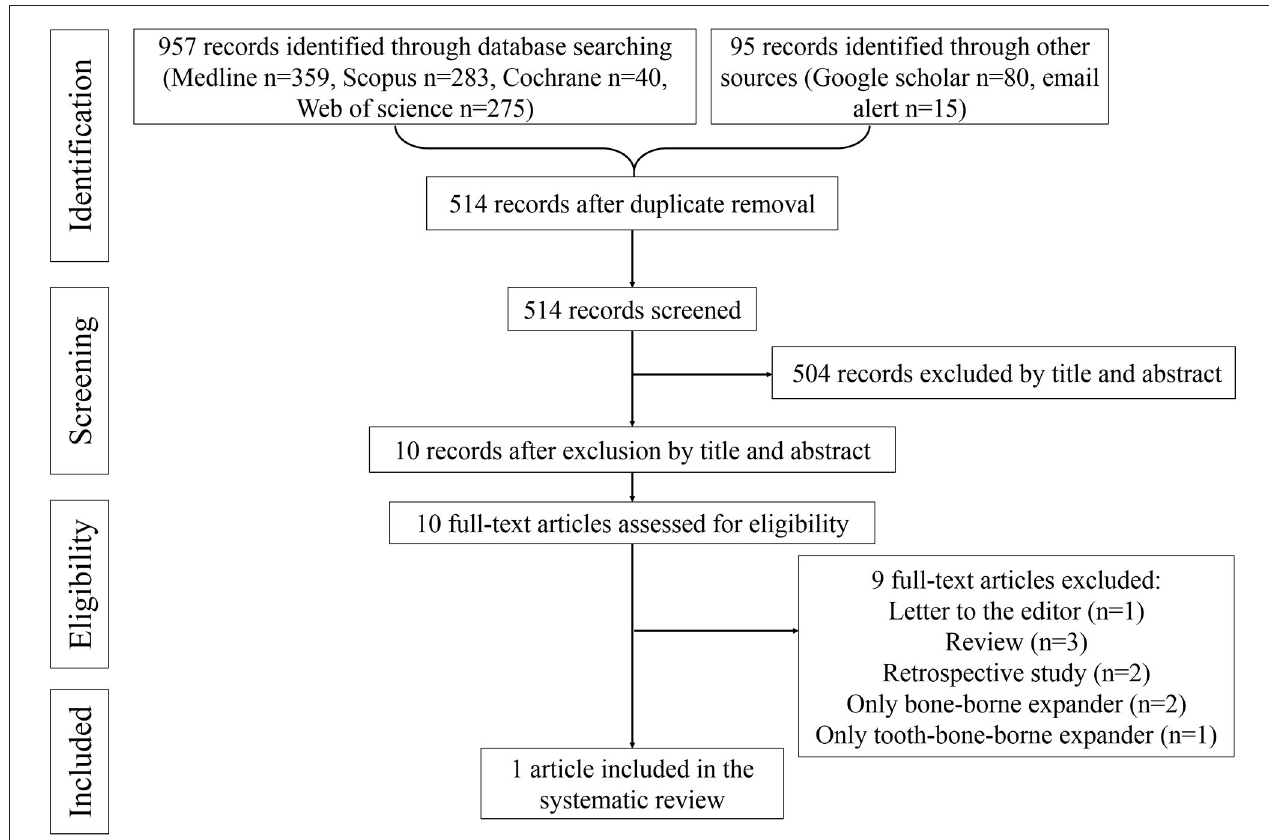
FIGURE 1 | Flowchart of the study selection process based on PRISMA statement.